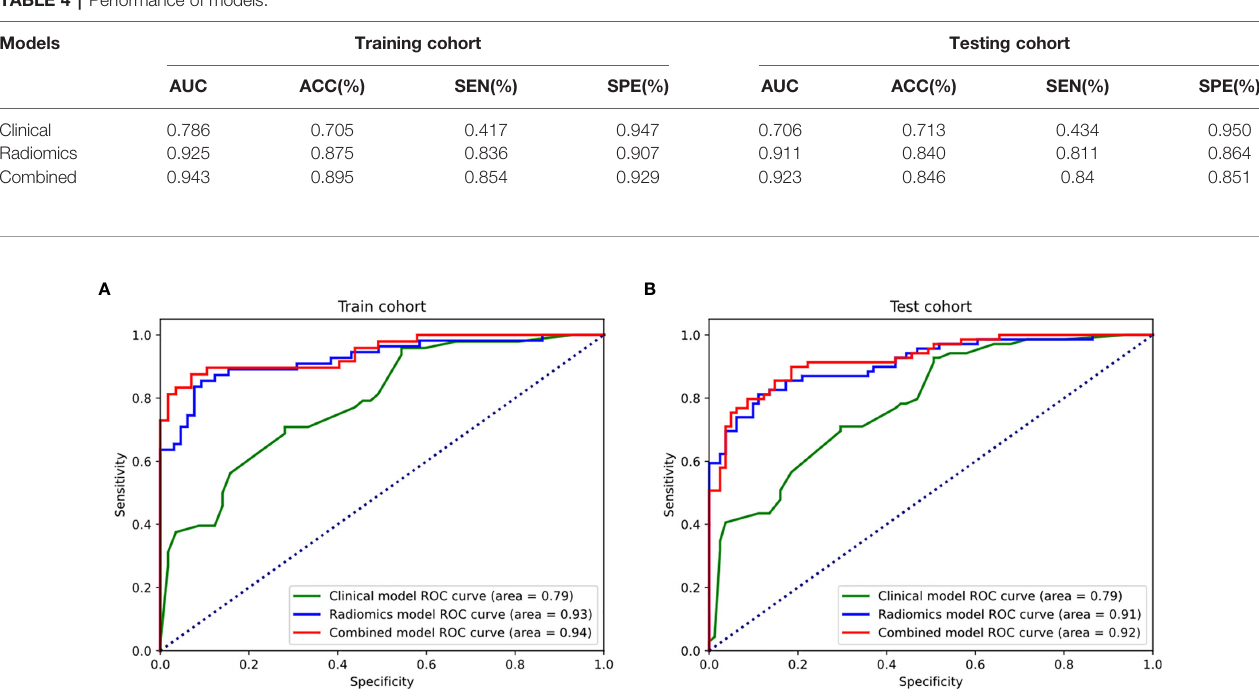
FIGURE 5 | The ROC curves of the clinical model, radiomics models, and combined model in the training cohort (A) and testing cohort (B)